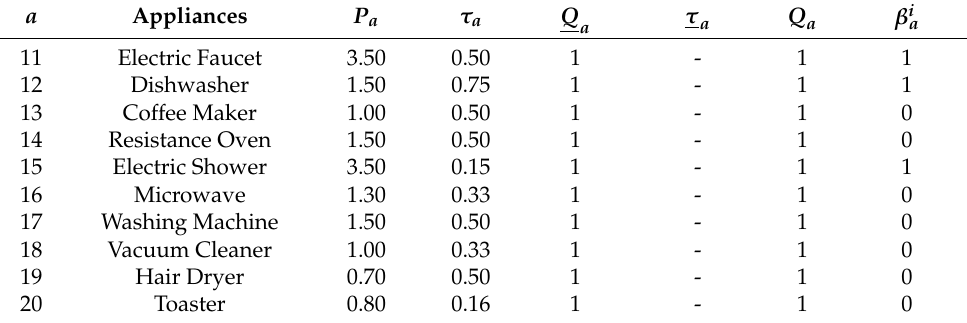
Table 2. Technical Data related to Home Appliances with β a = 0.